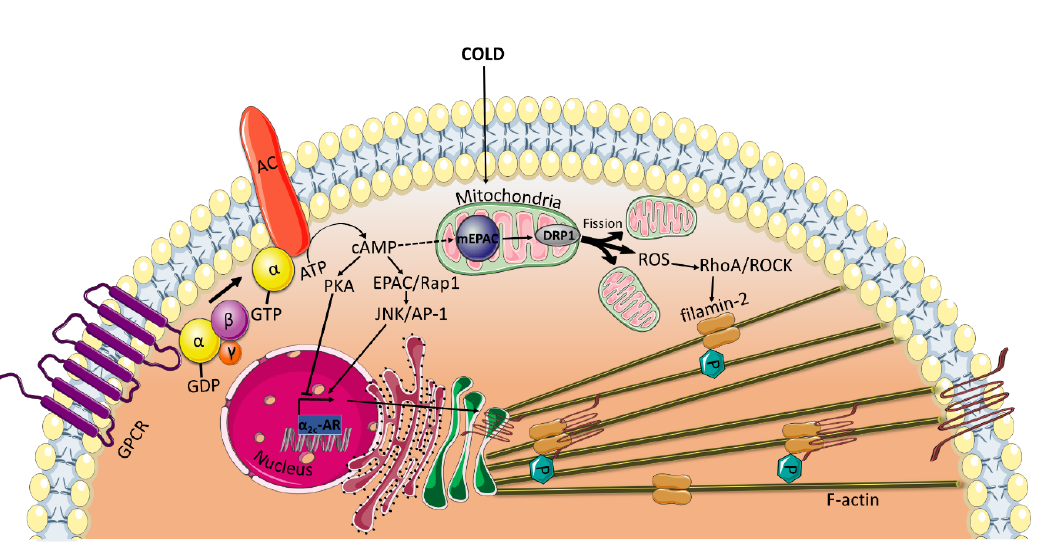
Figure 3. EPAC mediates cold-induced constriction in microVSMCs. Extreme cold temperatures induce the release of reactive oxygen species (ROS) form the mitochondria. Alternatively, ROS may be generated by DRP1-induced mitochondrial fission driven by mEPAC. ROS then activates RhoA / ROCK pathway, which phosphorylates filamin-2 required for the translocation of α 2C -ARs from the transGolgi to the cell surface where they induce vasoconstriction. EPAC also plays a role in increasing the α 2C -ARs transcription by activating JNK / AP-1 and in the translocation of the receptor by activating RhoA / ROCK. DRP1: Dynamin-related protein; mEPAC: mitochondrial EPAC.